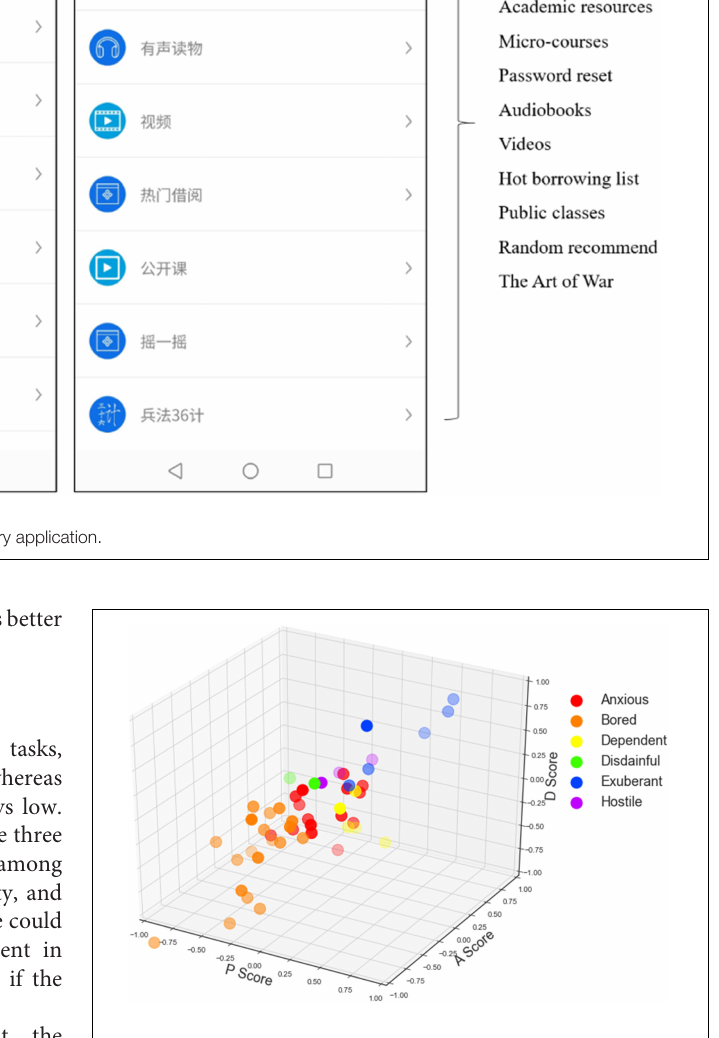
FIGURE 4 | The scatter plot of participants’ Pleasure-Arousal-Dominance (PAD) scores of the user interface (For Figures 4 – 6 , the x -axis represents the pleasure score, the y -axis represents the arousal score, and the z -axis represents the dominance score. The colors represent different emotion